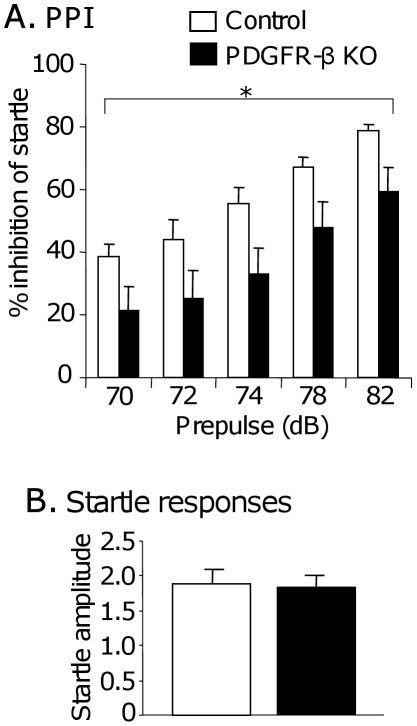
Prepulse inhibition (PPI) of acoustic startle responses.A: PPI (%) at 5 different prepulse intensities (70, 72, 74, 78, and 82 dB). The PDGFR-β KO mice displayed significantly less PPI than the control mice [F(1, 30) = 5.902; p<0.05; control, n = 16; KO, n = 16]. B: Acoustic startle amplitudes measured in trials without a prepulse. No significant differences were observed in the acoustic startle amplitudes of the 2 groups of mice. Values indicate the mean ± SE. White columns, control mice, n = 16; black columns, PDGFR-β KO mice, n = 16.